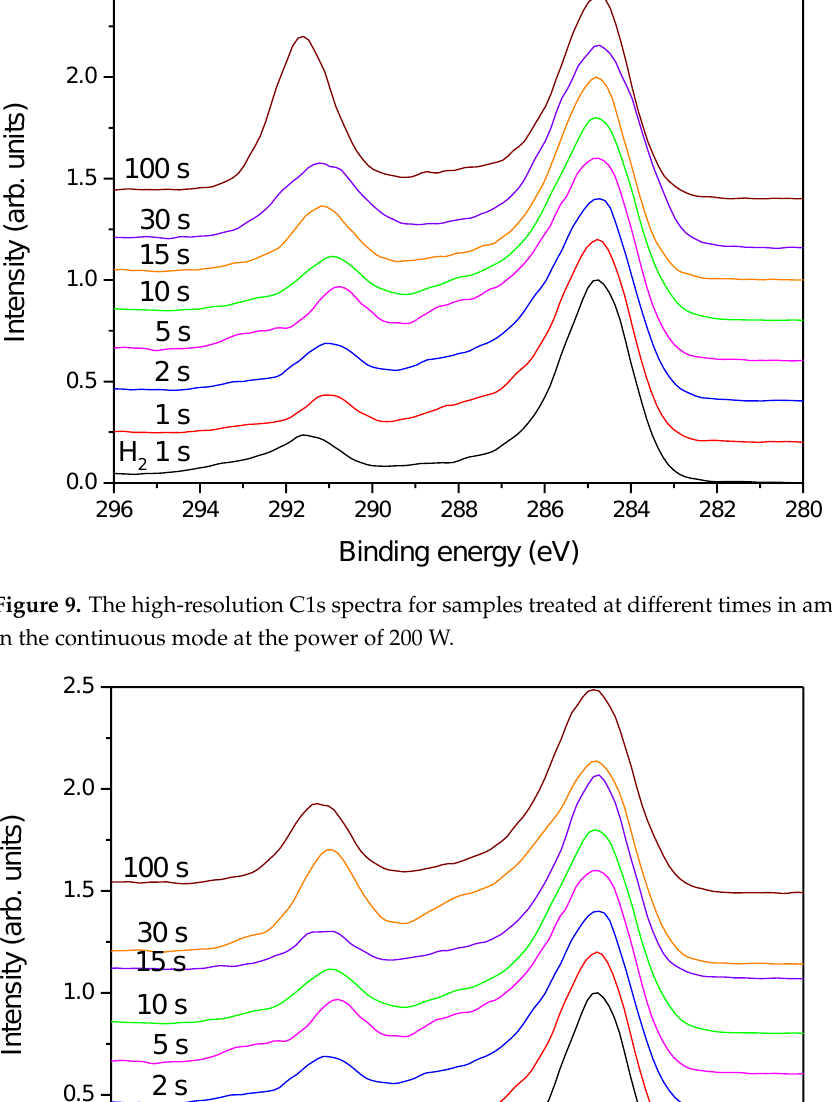
Figure 8. Evolution of high-resolution peaks of: ( a ) carbon and ( b ) nitrogen with detection depth.